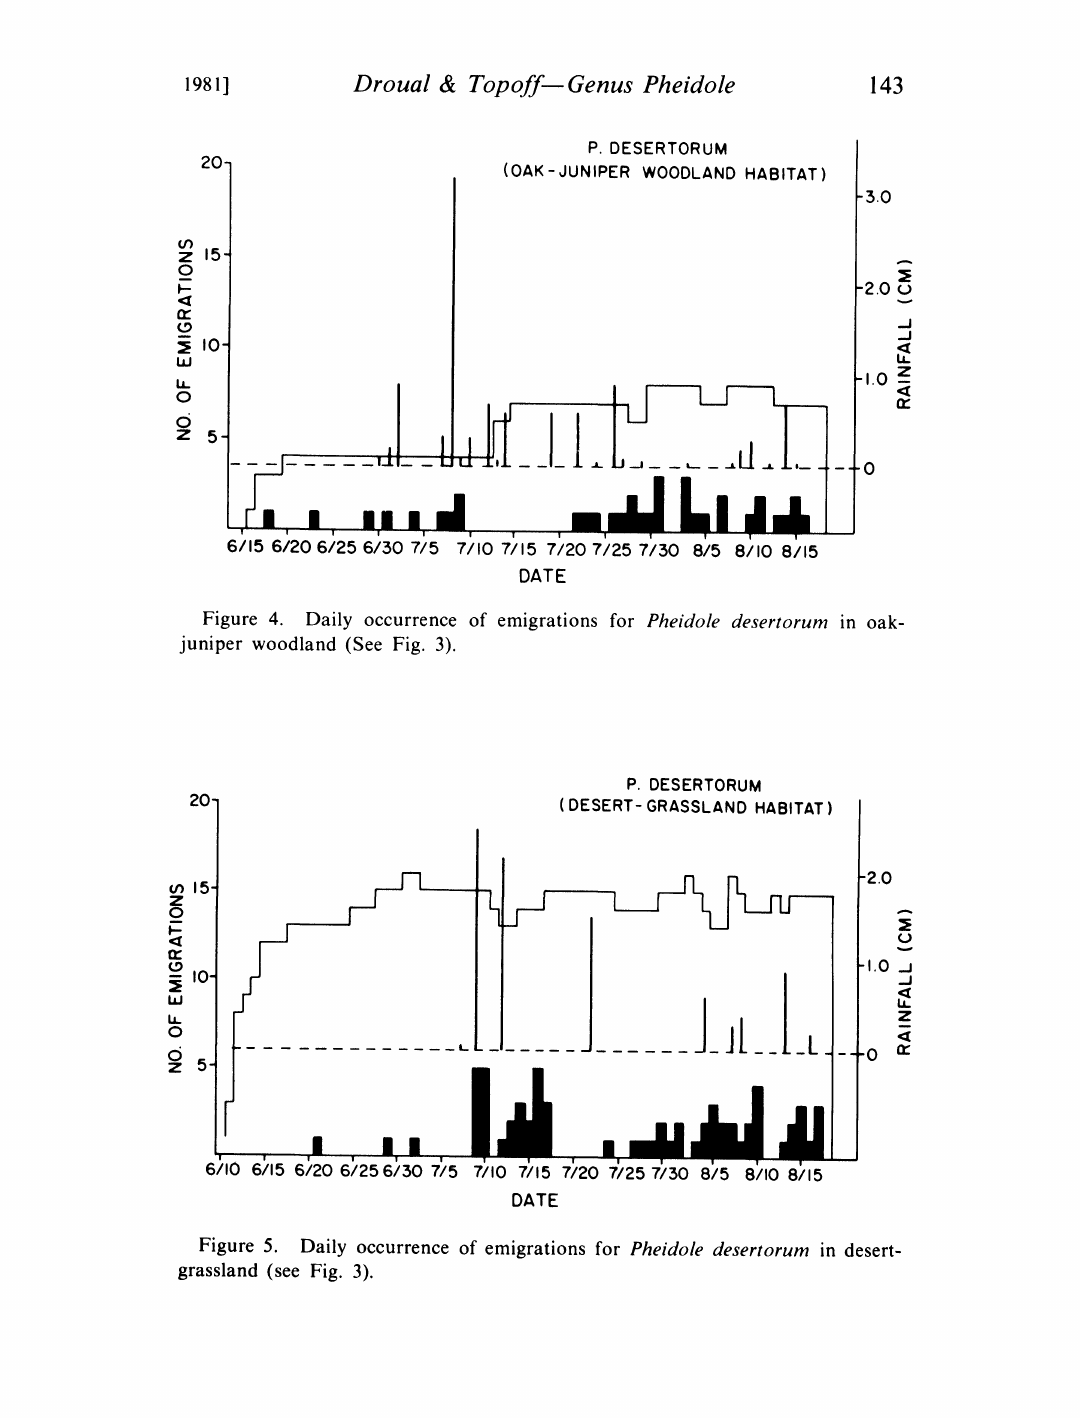
Figure 5. Daily occurrence of emigrations for Pheidole desertorum in desert- grassland (see Fig.